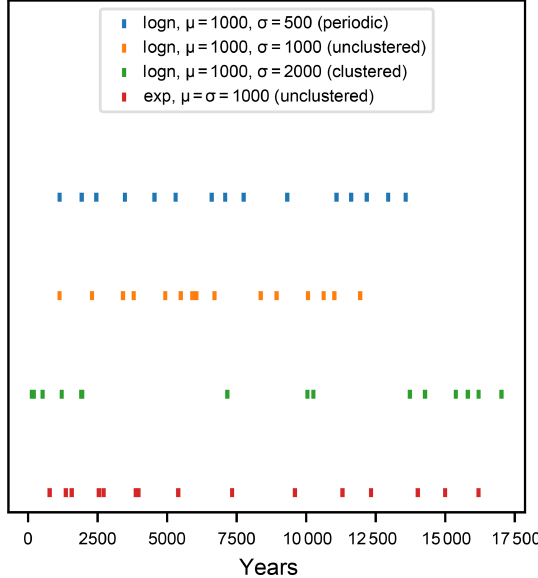
Figure 2. Spacing of 15 simulated successive earthquakes from each recurrence distribution. Note that the gap between the last dis- played earthquake and the right side of the plot does not represent a long recurrence